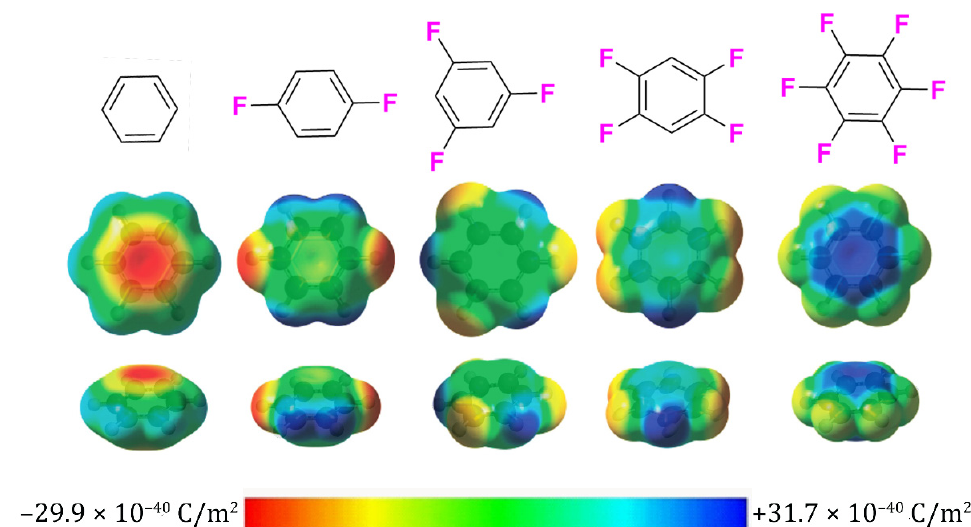
Figure 1. Fluorinated substituent effects on an aromatic π system. Bond-line structures of each system are presented alongside a top and side view of their electrostatic potential maps generated using the Hartree–Fock method in Spartan’18 with the 6-311+G** basis [11]. As more fluorine substituents are appended, the electron-rich π -donor core of the benzene inverts to become an electron-deficient π -acceptor. A rainbow color coded scale ranging from positive blue to negative red depict the spectrum of electrostatic potentials.